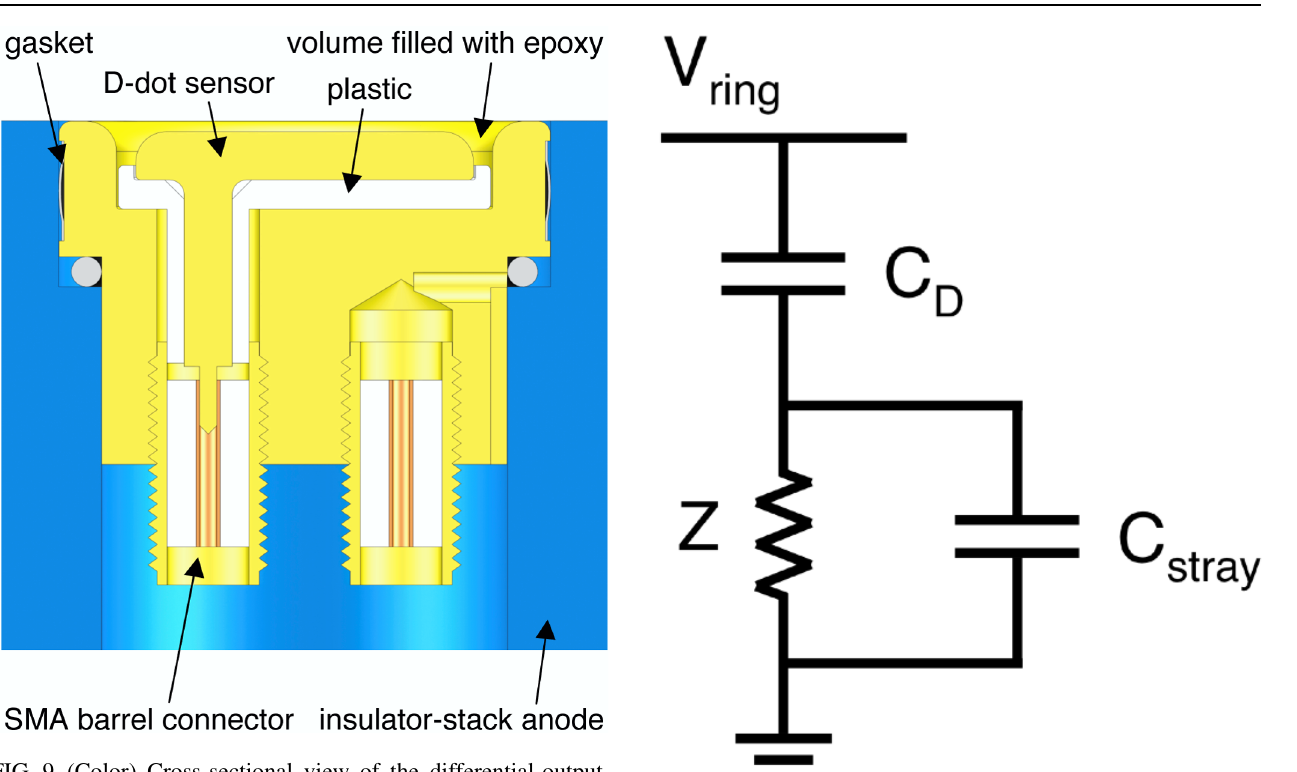
9. (Color) Cross-sectional view of the differential-output D -dot voltage monitor that is fielded on the insulator stack of the Z